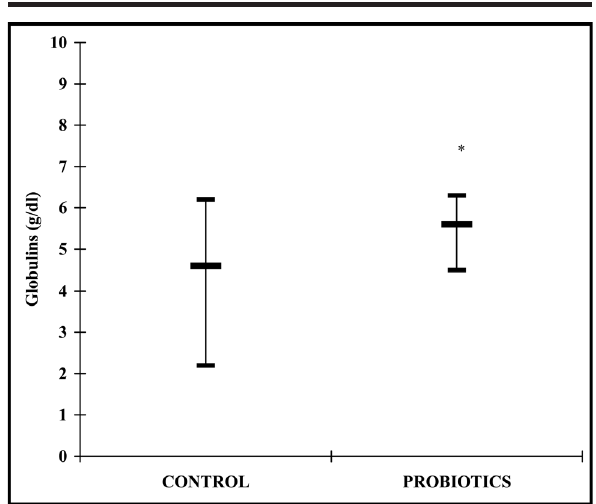
FIGURE 2 - Serum globulins at the pre-operative period in the two groups. * p<0,05 vs controls.